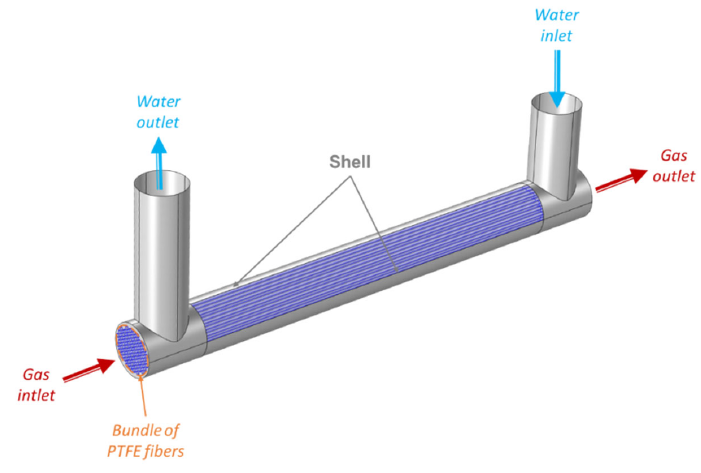
Figure 1. Configuration of the membrane